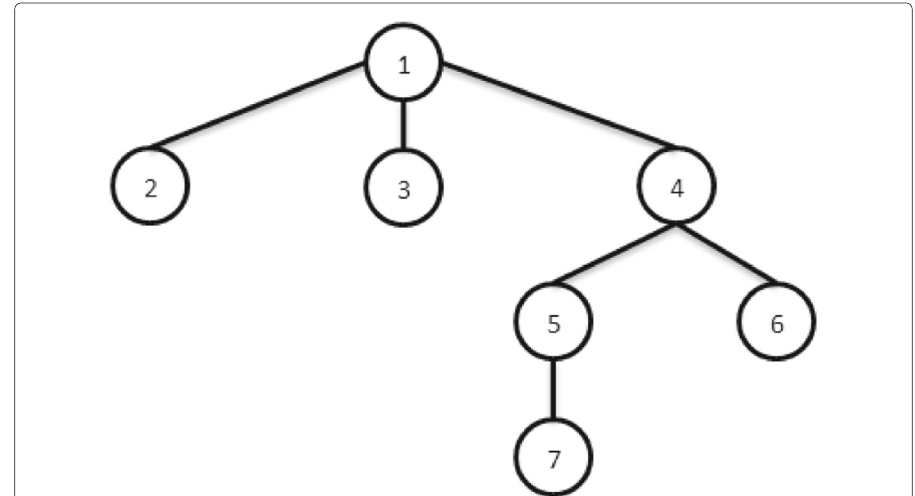
Fig. 2 Example for middle vertex